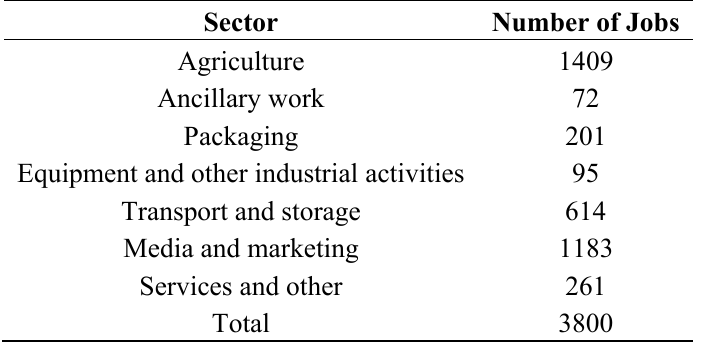
Table 1. Indirect employment thanks to the beer industry in